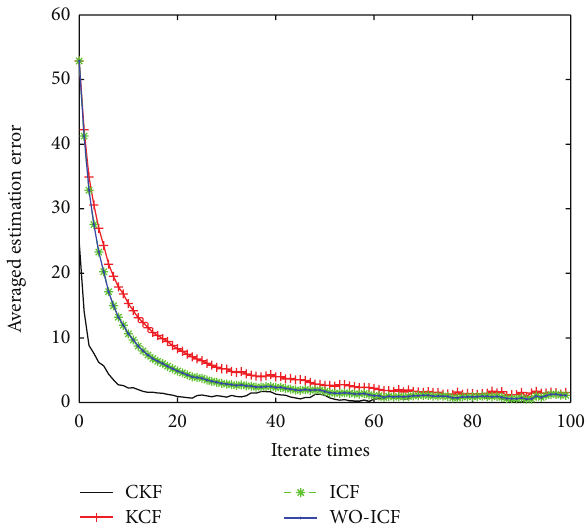
Figure 3: The averaged estimation errors of different algorithms.